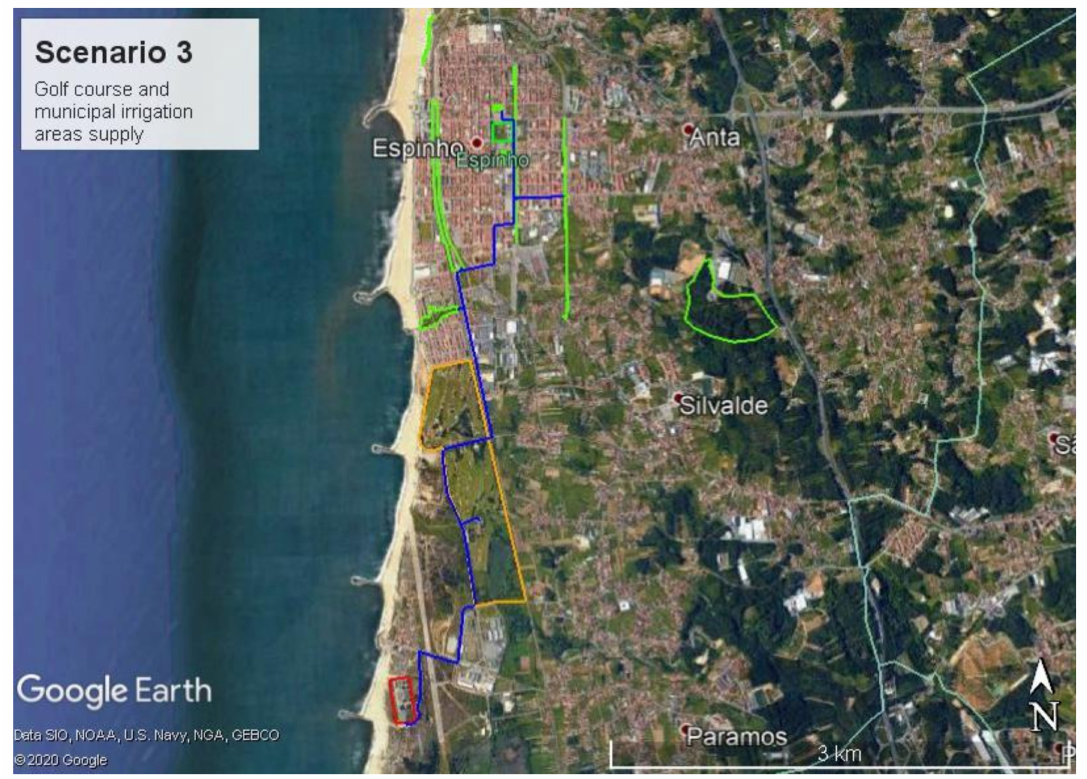
Figure 7. Scenario 3: WtR supply, provided by Espinho WWTP (in red), by pressurized network (pipe in blue) to the Oporto Golf Club bordered in orange and to the municipal irrigation areas marked in green. Table 5. Scenario 3: Supply with drinking water and WtR to the golf course and municipal irrigation areas.